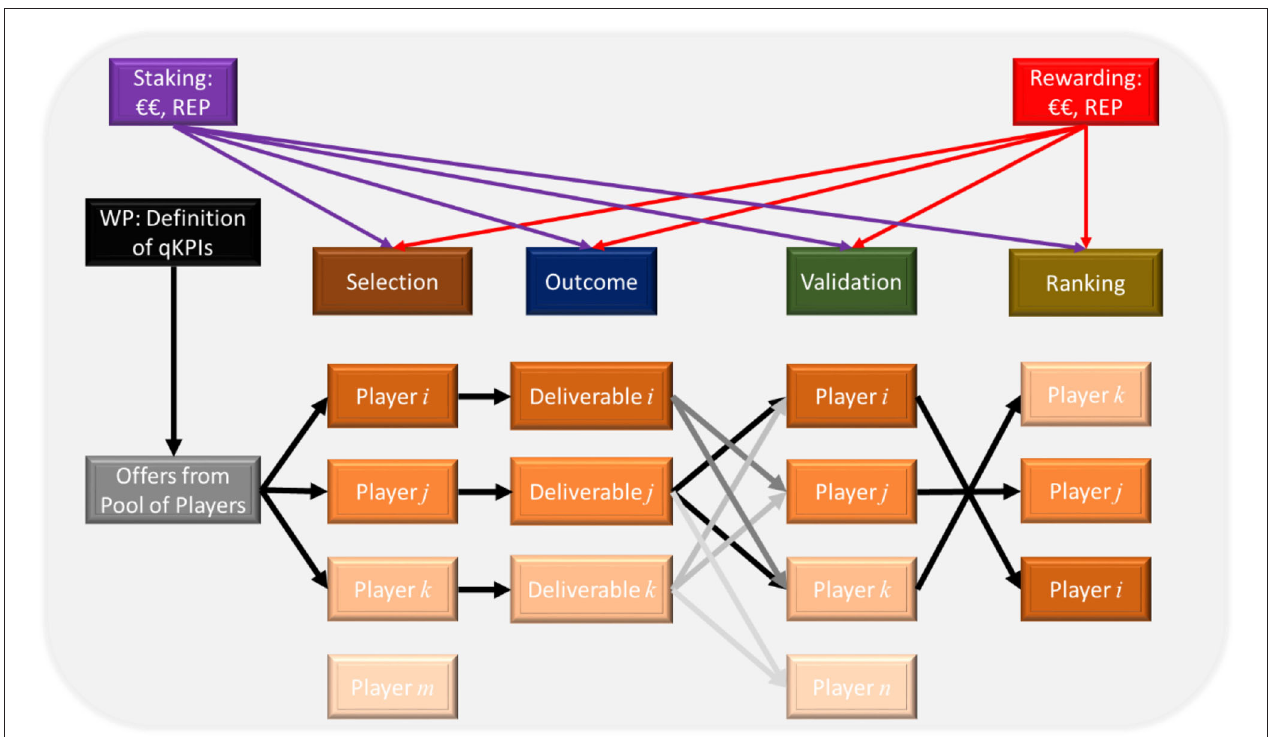
FIGURE 5 | Competitive parallelization. A system integrator or buyer crowdsources the work, e.g., on RTD or manufacture from independent players. The buyer selects a subgroup of players according to their offers. The outcomes are ranked, as much as possible, by a validation panel according to quantitative Key Performance Indicators. Bidders can increase their chance of acceptance by staking while quality work is rewarded by assets and